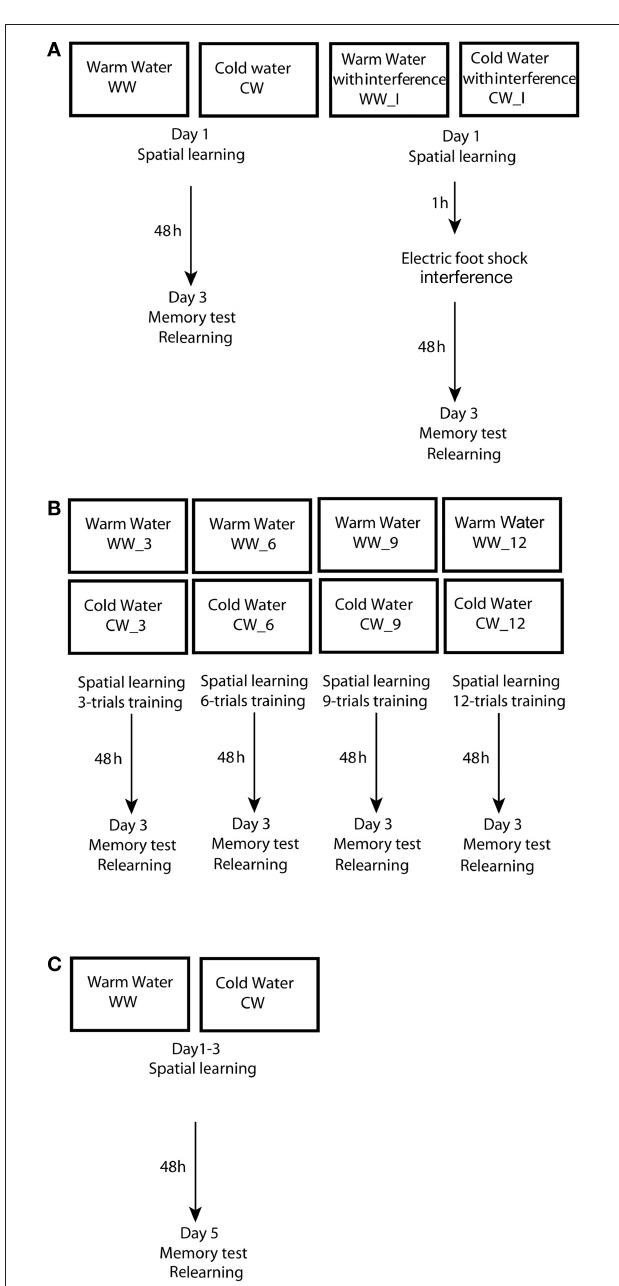
Figure 1 | experimental design used in the study. (A) Design of experiment 1 – spatial learning and memory formation in the Morris water maze under warm or cold water conditions, with an electrical foot shock interference; (B) Design of experiment 2 – acquisition threshold for spatial memory formation in the Morris water maze under warm or cold water conditions; (C) Design of experiment 3 – spatial learning and memory formation in the Morris water maze under warm or cold water conditions.